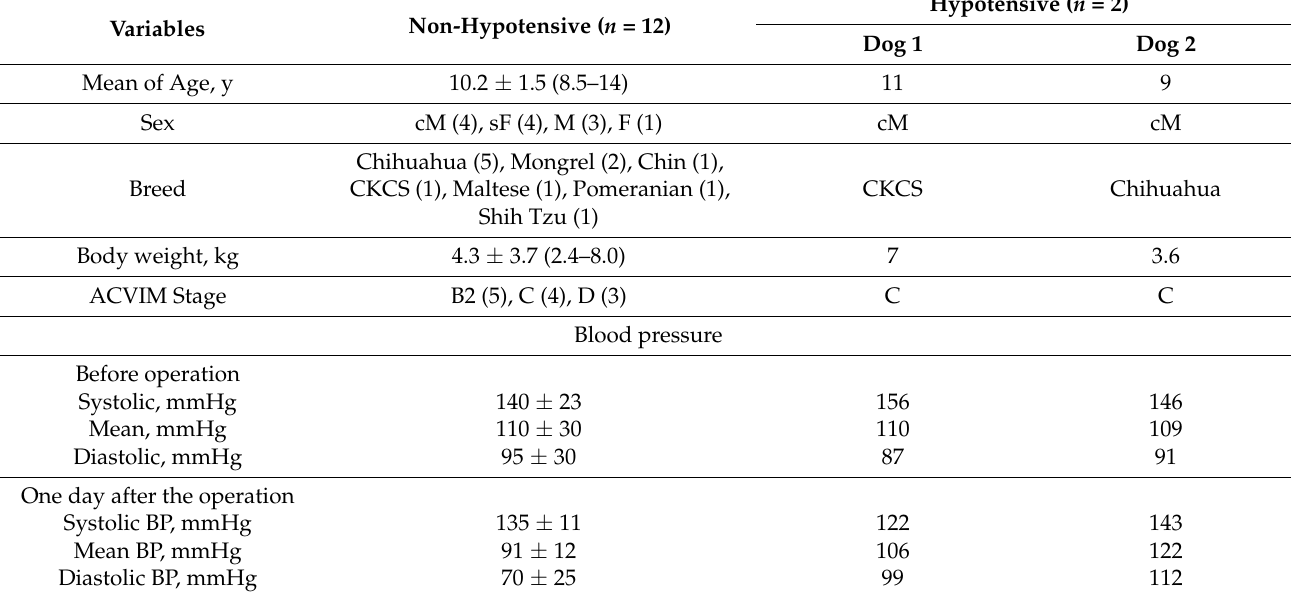
Table 1. Clinical characteristics, ACVIM stage, concurrent disease, and perioperative information of all